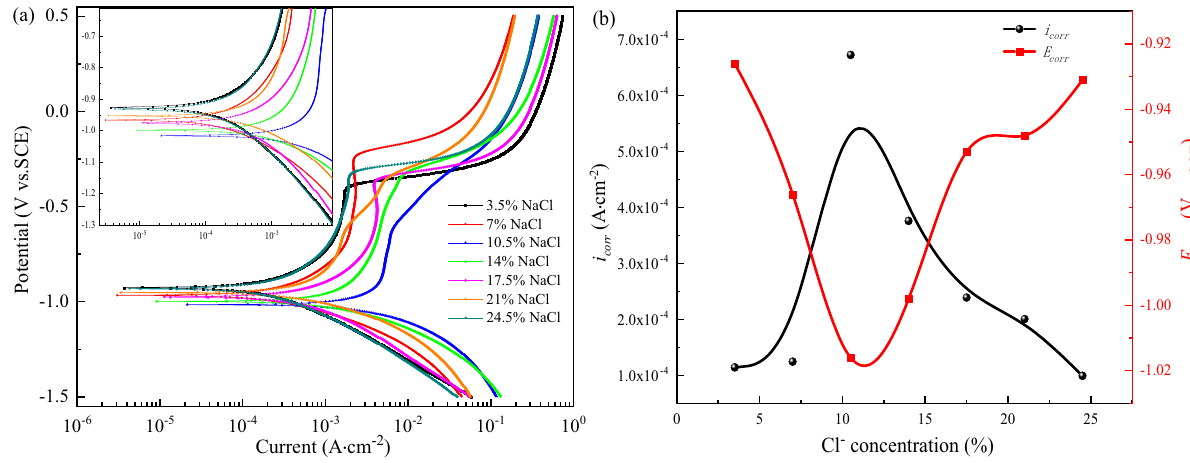
Figure 3: Potentiodynamic polarization curves of samples in di ff erent concentrations of NaCl solution: ( a ) electrochemical polarization curve; ( b ) Curves of Cl − concentration vs E corr and i corr .